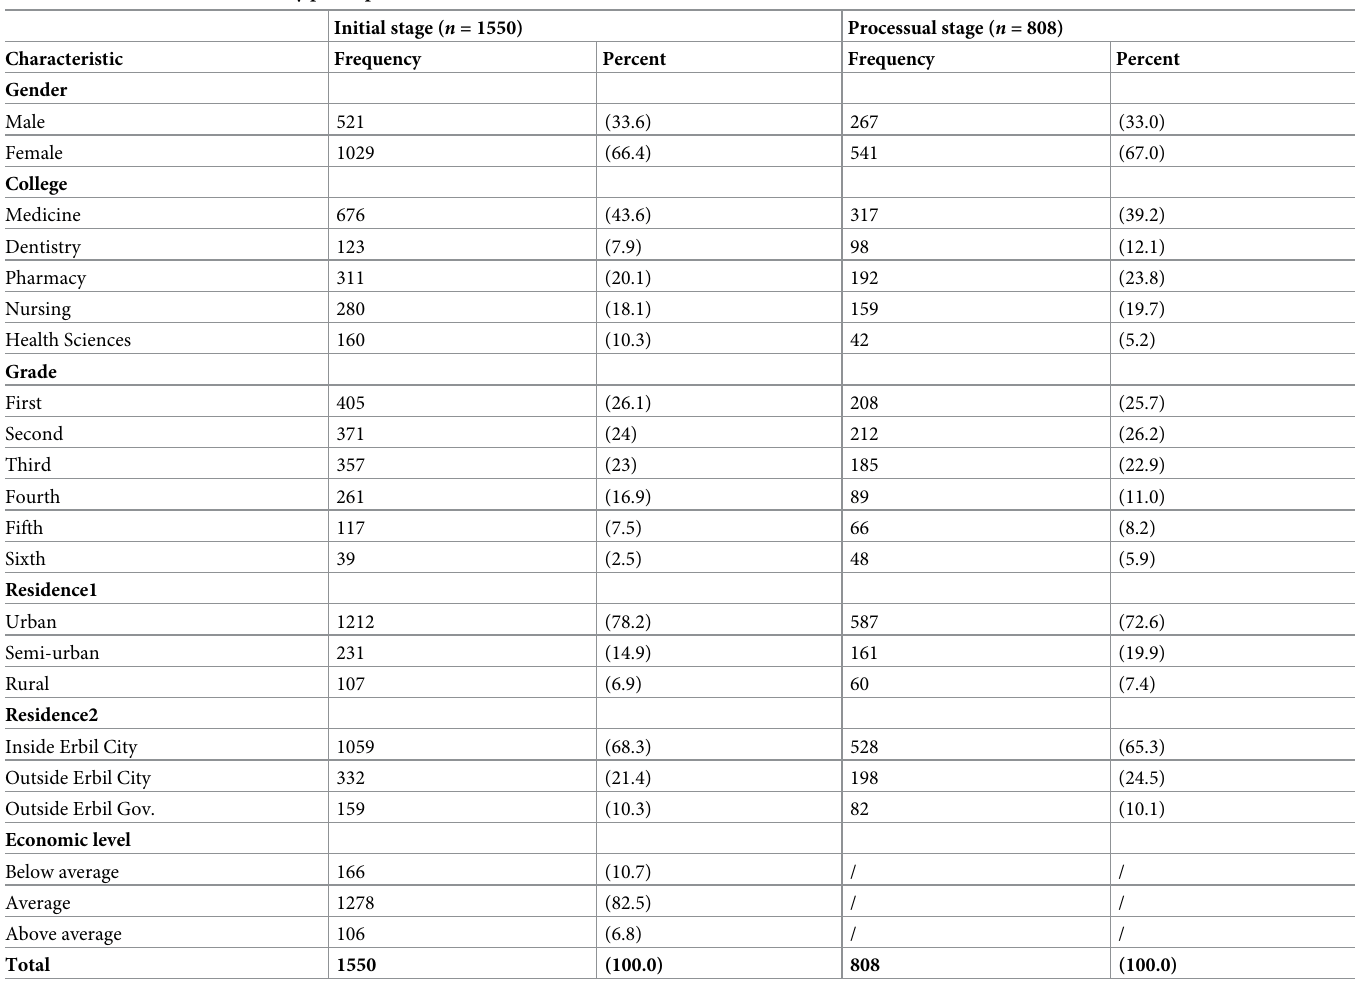
Table 1. Characteristics of the study